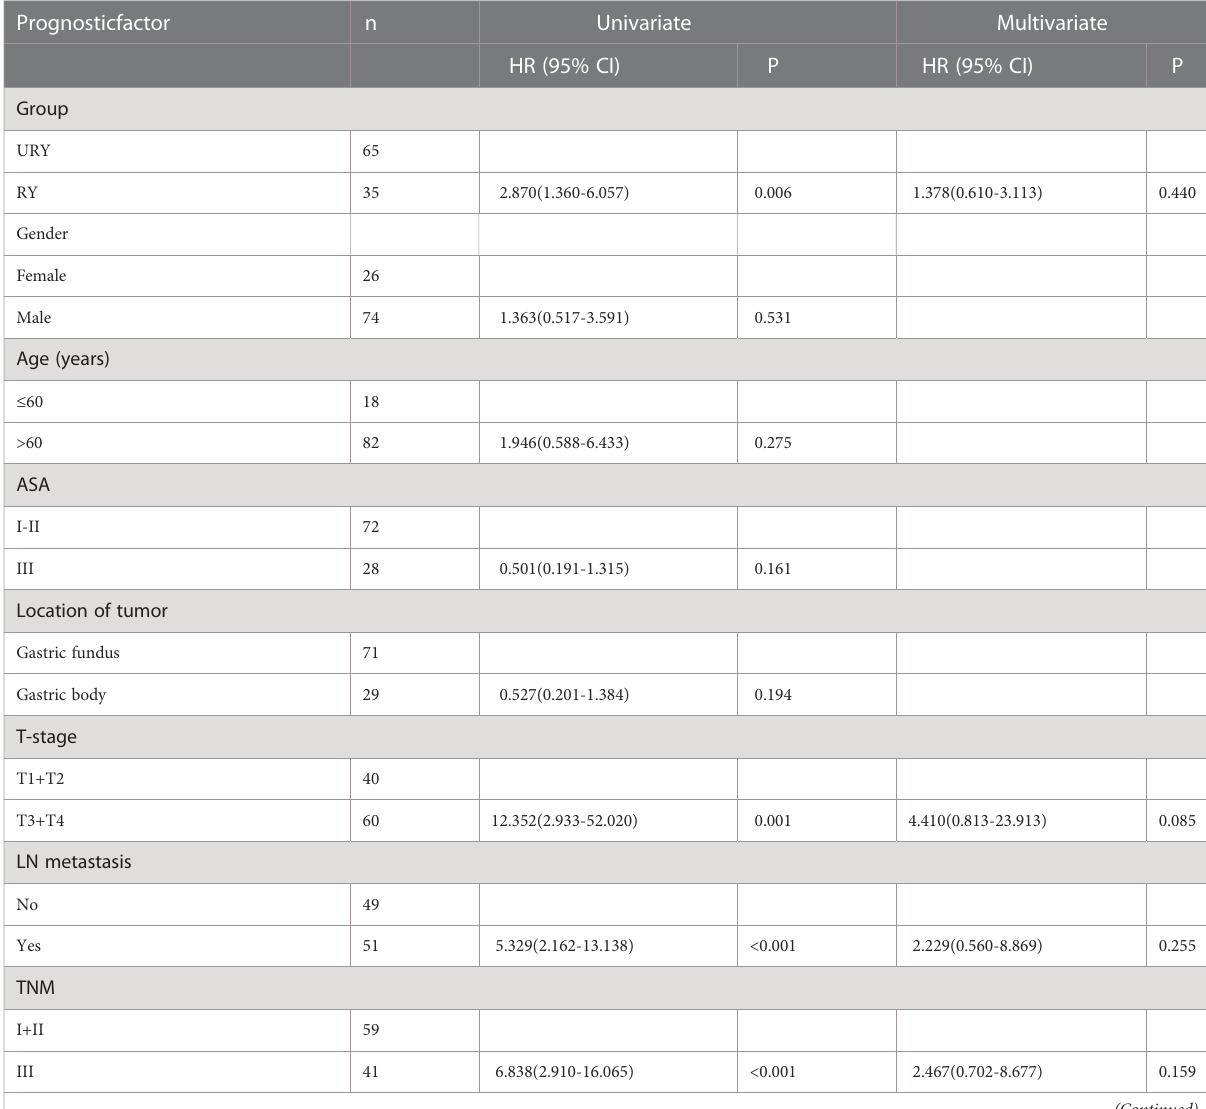
TABLE 7 Analysis of prognostic factors associated with